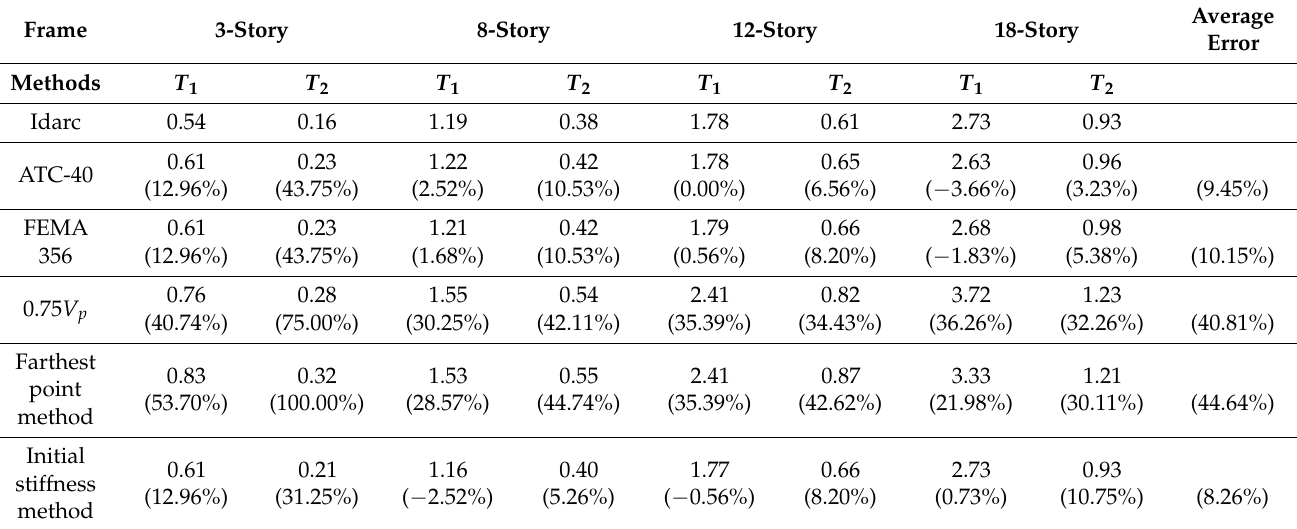
Figure 8. Idealization of the actual story capacity curves (using 12-story frame as an example). Table 2. Errors of first and second periods calculated by using different